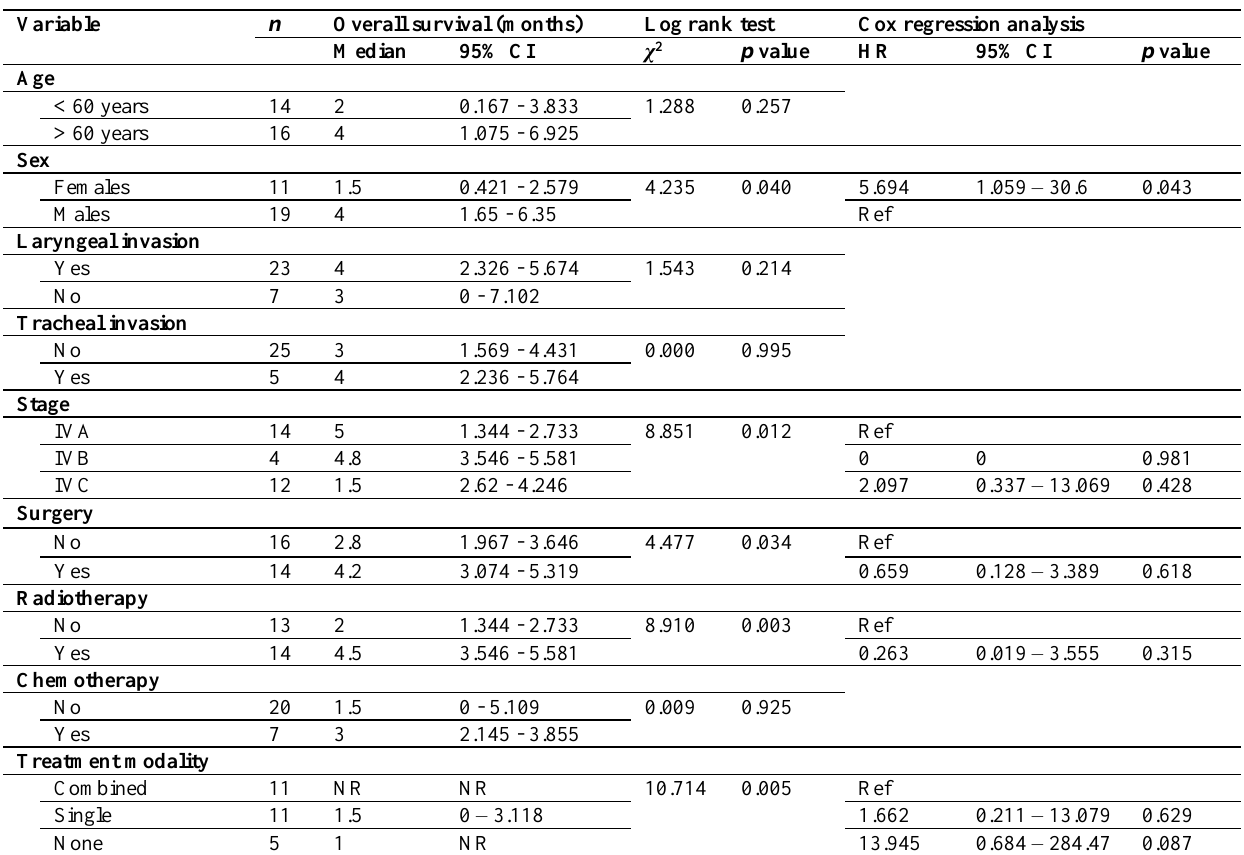
Table 4: Univariate and multivariate analysis of factors affecting overall survival